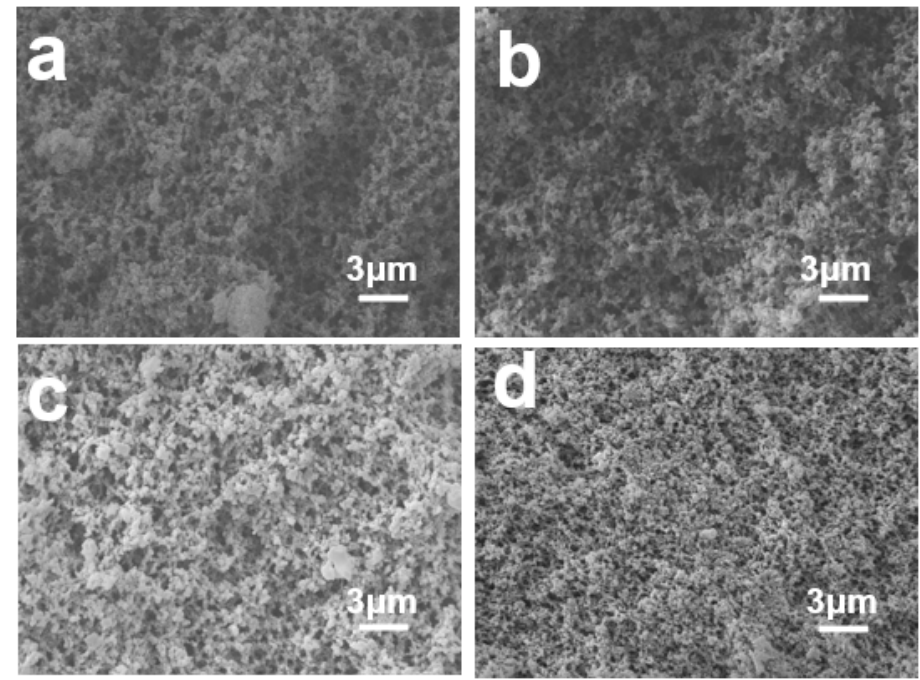
Figure 3. SEM Images of ( a ) PBa; ( b ) PBa/DQ-1%; ( c ) PBa/DQ-3%; and ( d ) PBa/DQ-5%.